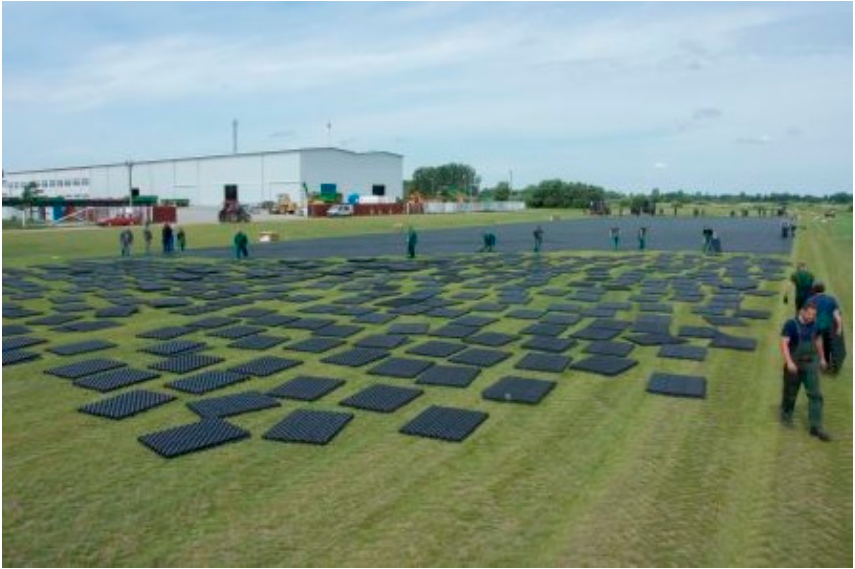
Figure 4. Laying the geocell on the natural pavement of the runway.